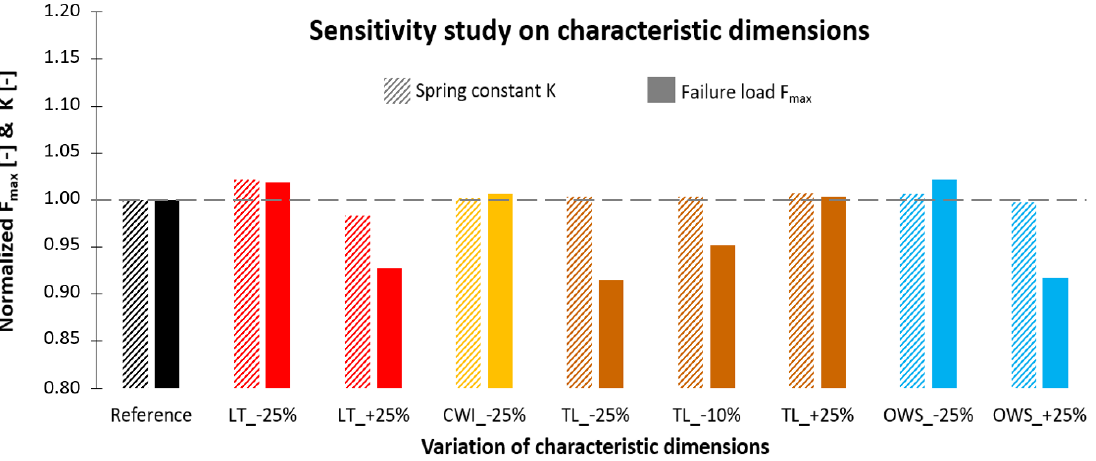
Figure 12. Influence of varied characteristic dimensions on the mechanical behavior of a macro-model.